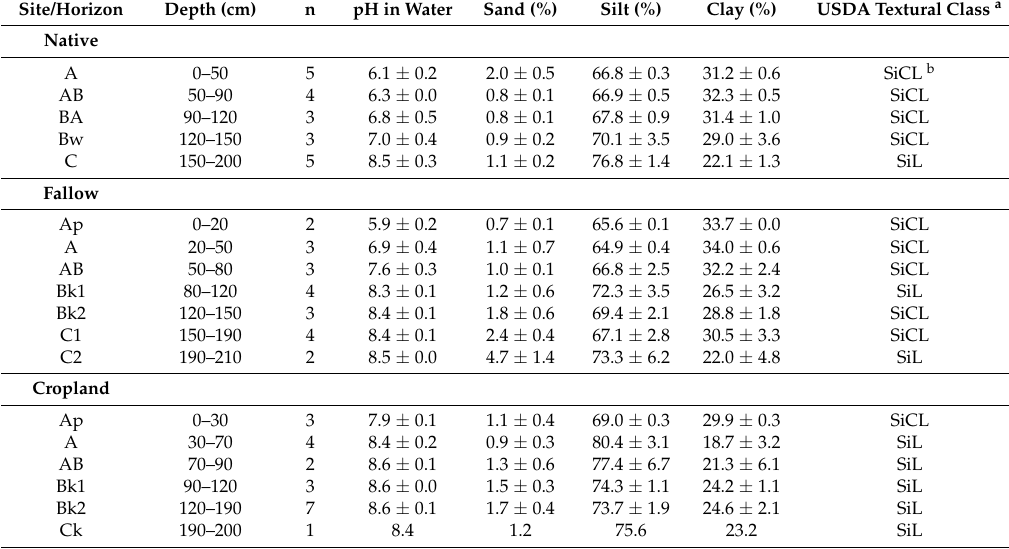
Table 2. Selected soil properties with depth and site in the representative soil profile: mean ± standard deviation (adapted from [38]).